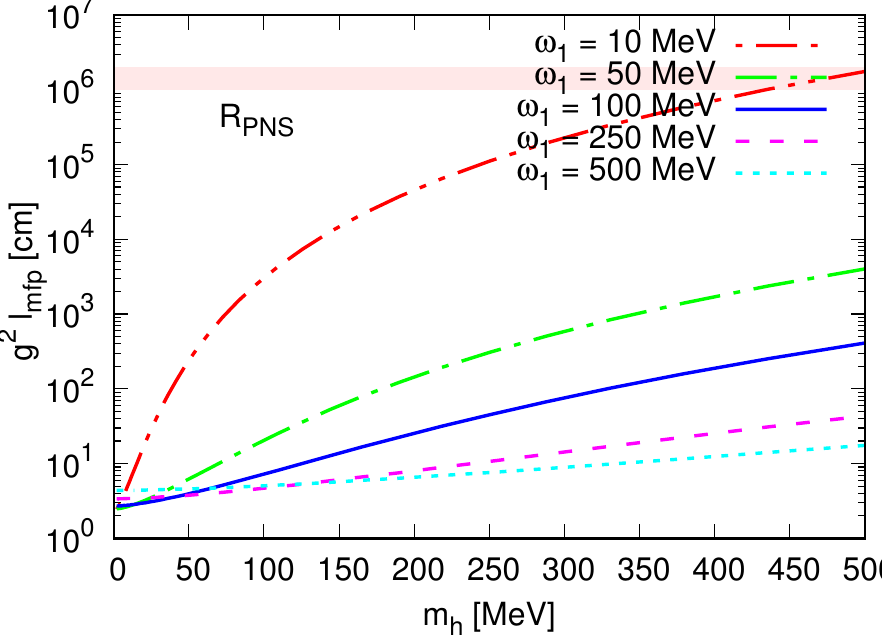
Figure 6 . Goldstone boson mean free path l mfp times the Higgs portal coupling g 2 in the proto- neutron star core versus the light Higgs boson mass m h . Here we show the dependence on the incident Goldstone boson energy for the values ! 1 = 10 (dash double-dotted), 50 (dash-dotted), 100 (solid), 250 (dashed), and 500 MeV (dotted), respectively. Also shown is the proto-neutron star radius R PNS (cid:25) 10{20 km (shaded